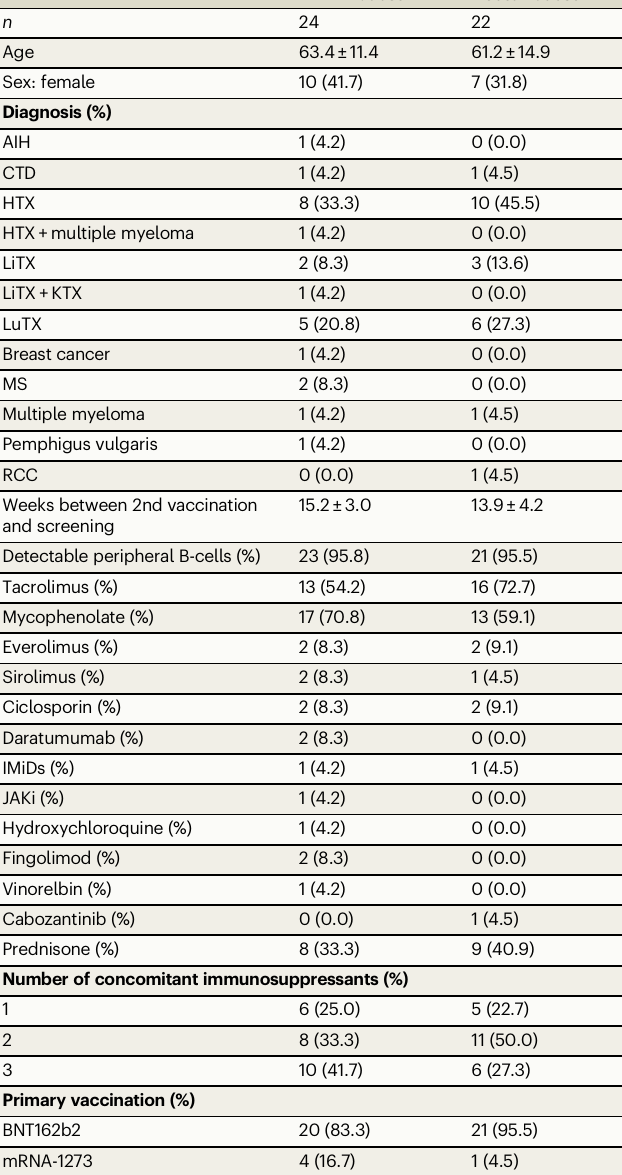
Table 1 | Patient characteristics at